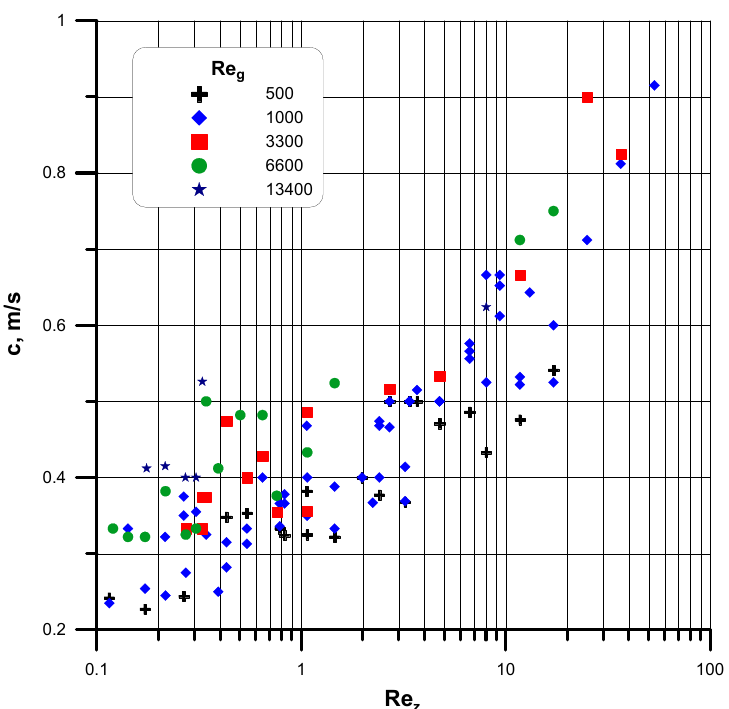
Figure 7. Results of experiments and calculations of wave velocity c = f(Re z , Re g ) accompanying annular gas-very viscous liquid flow.